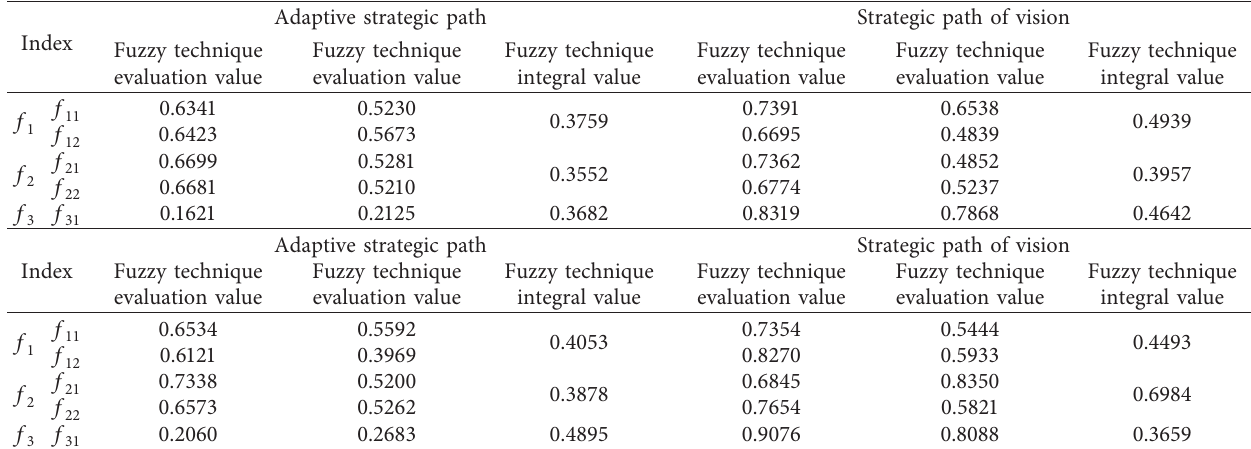
Table 7: ARR advanced intelligent manufacturing path selection three-level index and fuzzy technique integral value.